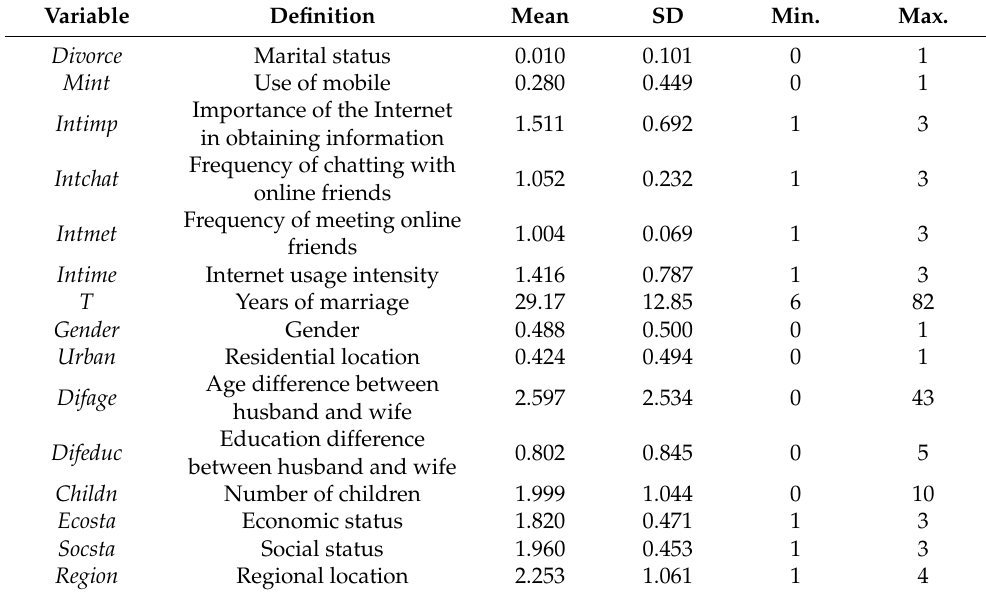
Table 1. Summary statistics of key variables for individual-level data ( N =